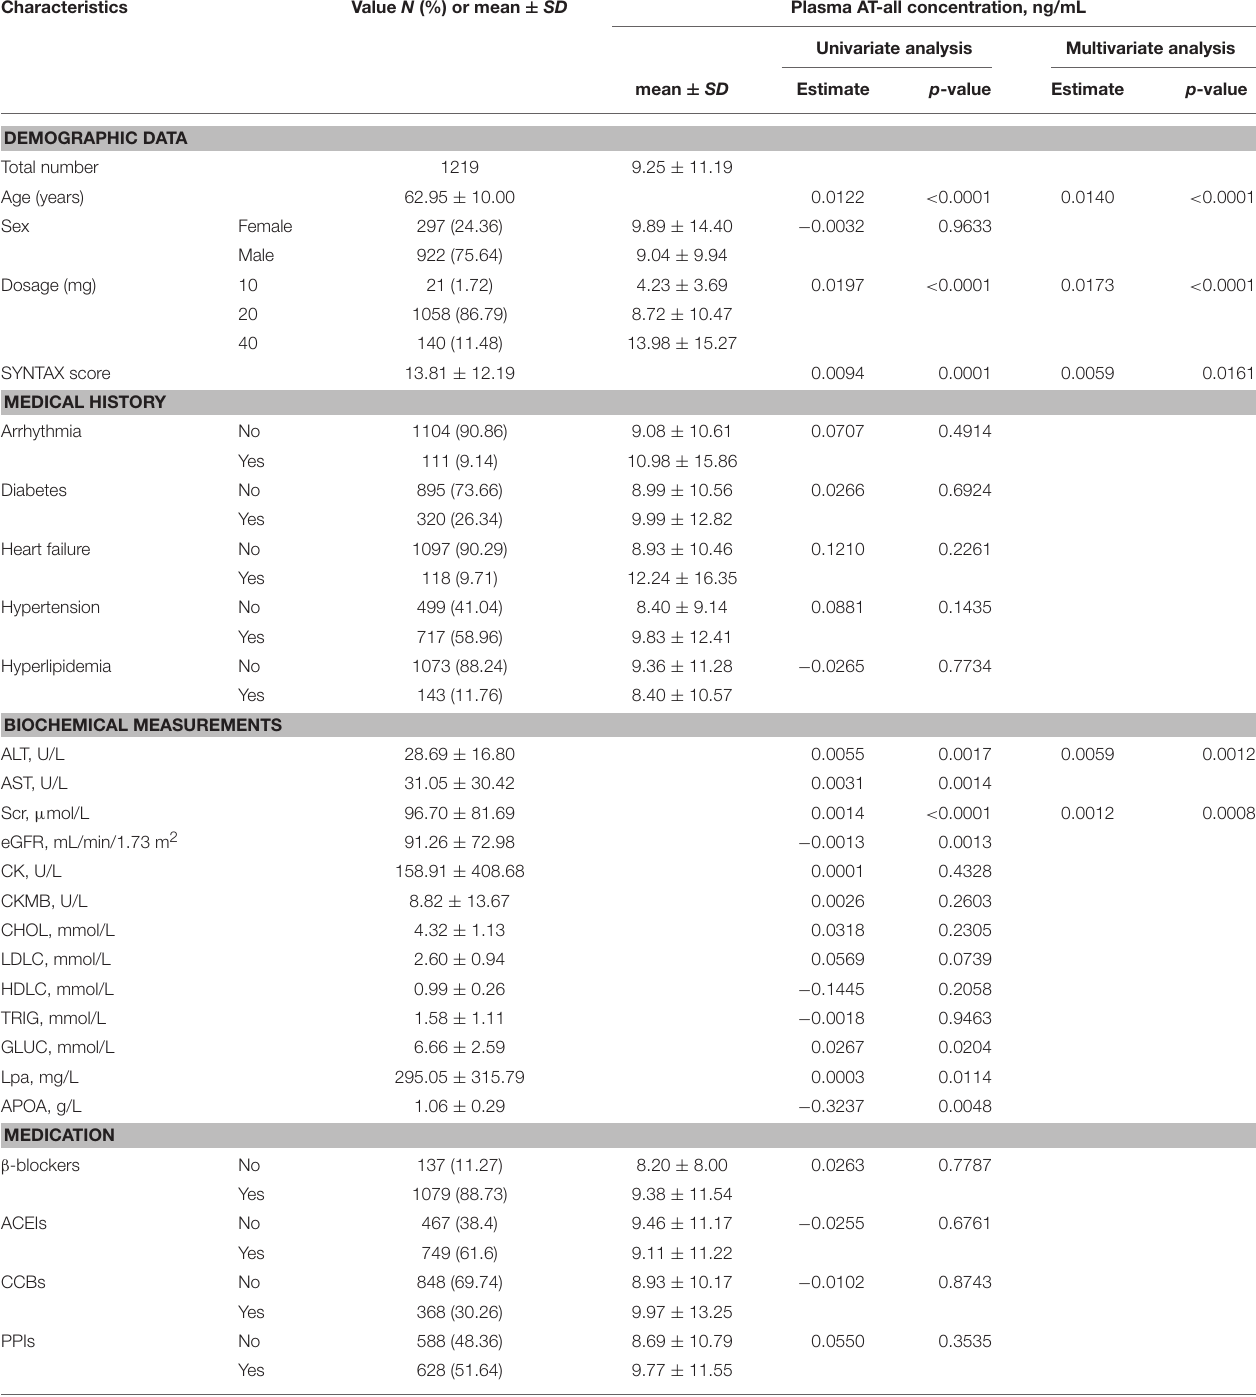
TABLE 1 | Patient characteristics and their effects on plasma concentration of AT-all.